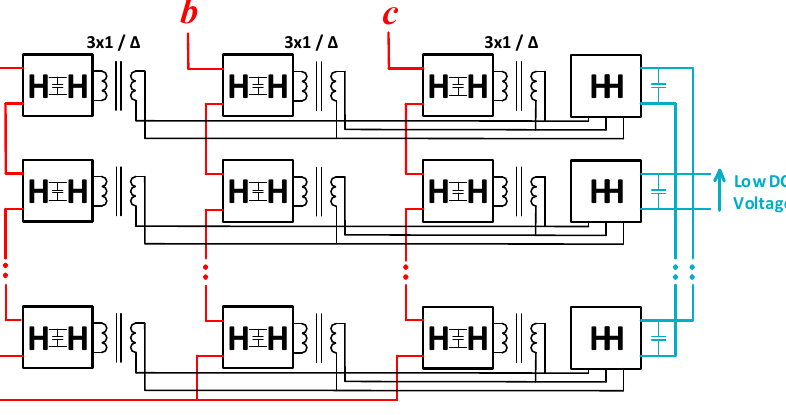
Figure 3. MV-AC to MV-DC stage of SST based on a star-connected CHB converter with IPOP DAB.